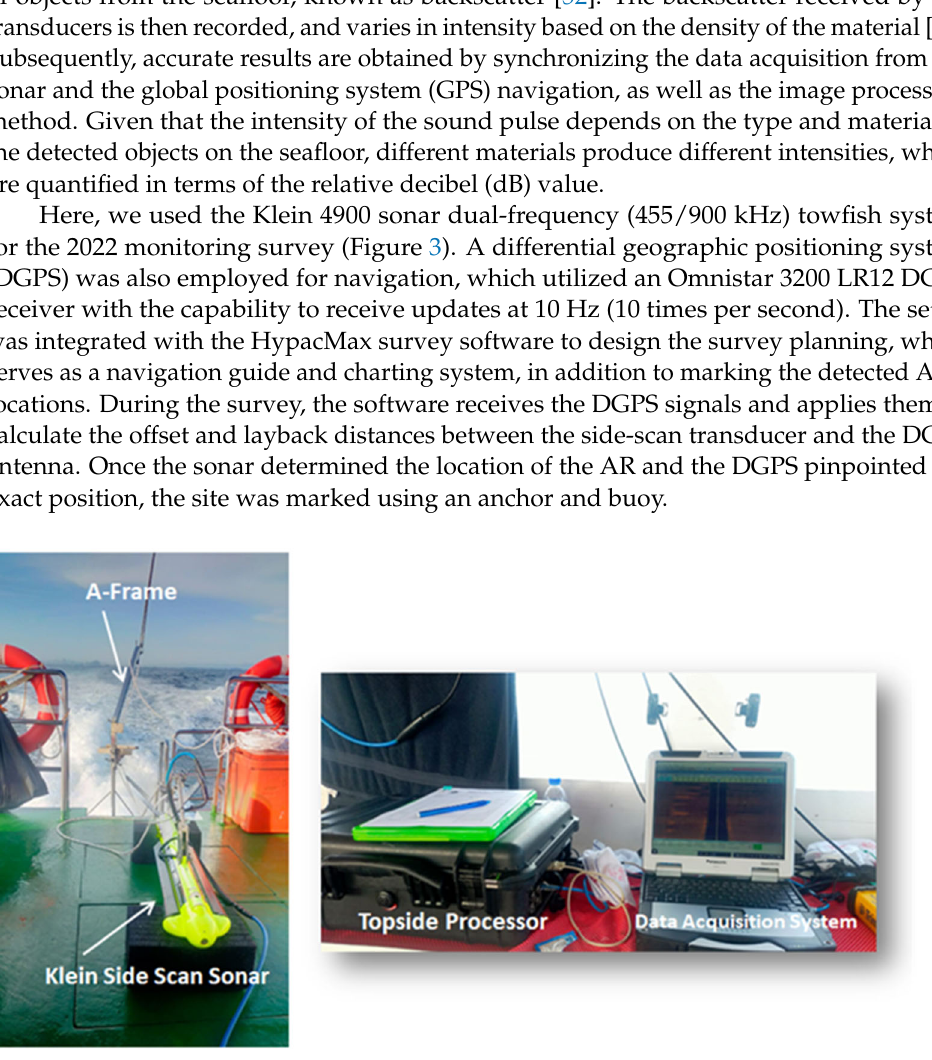
Figure 3. Side-scan sonar setup on Figure 3. Side ‐ scan sonar setup on board.